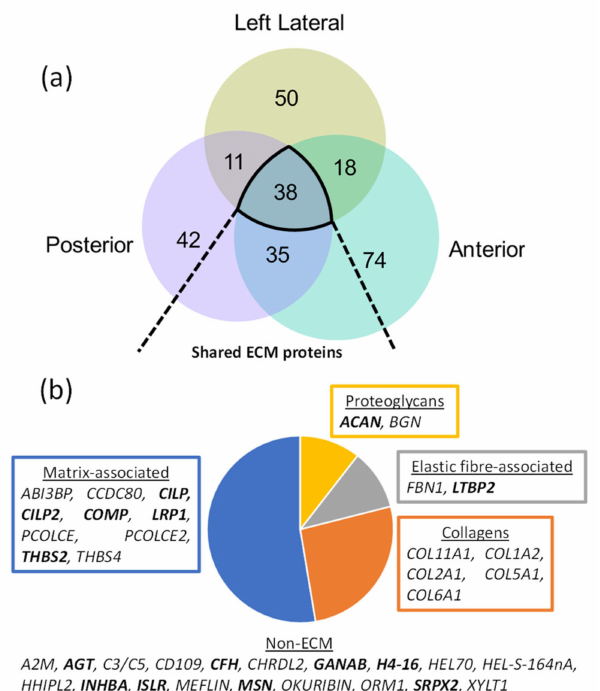
Figure 2. ECM-associated proteins make up half of the proteins identified with significant, age- associated structural differences in all three IVD regions. PLF revealed 126 proteins in posterior (Table S4), 117 in left lateral (Table S5) and 165 in anterior (Table S6) IVD regions with significant differences in peptide yield between aged and young IVDs, across their structures. ( a ) Of these, 38 were shared between the three regions. ( b ) Classification of these shared proteins revealed ECM as the major class, which included several ECM-associated proteins, collagens, two elastic fibre-specific proteins and two proteoglycans. The affected proteins which were uniquely discovered by PLF and not by label-free quantification of abundance in the DIPPER study [13] (Figure S3) are highlighted in